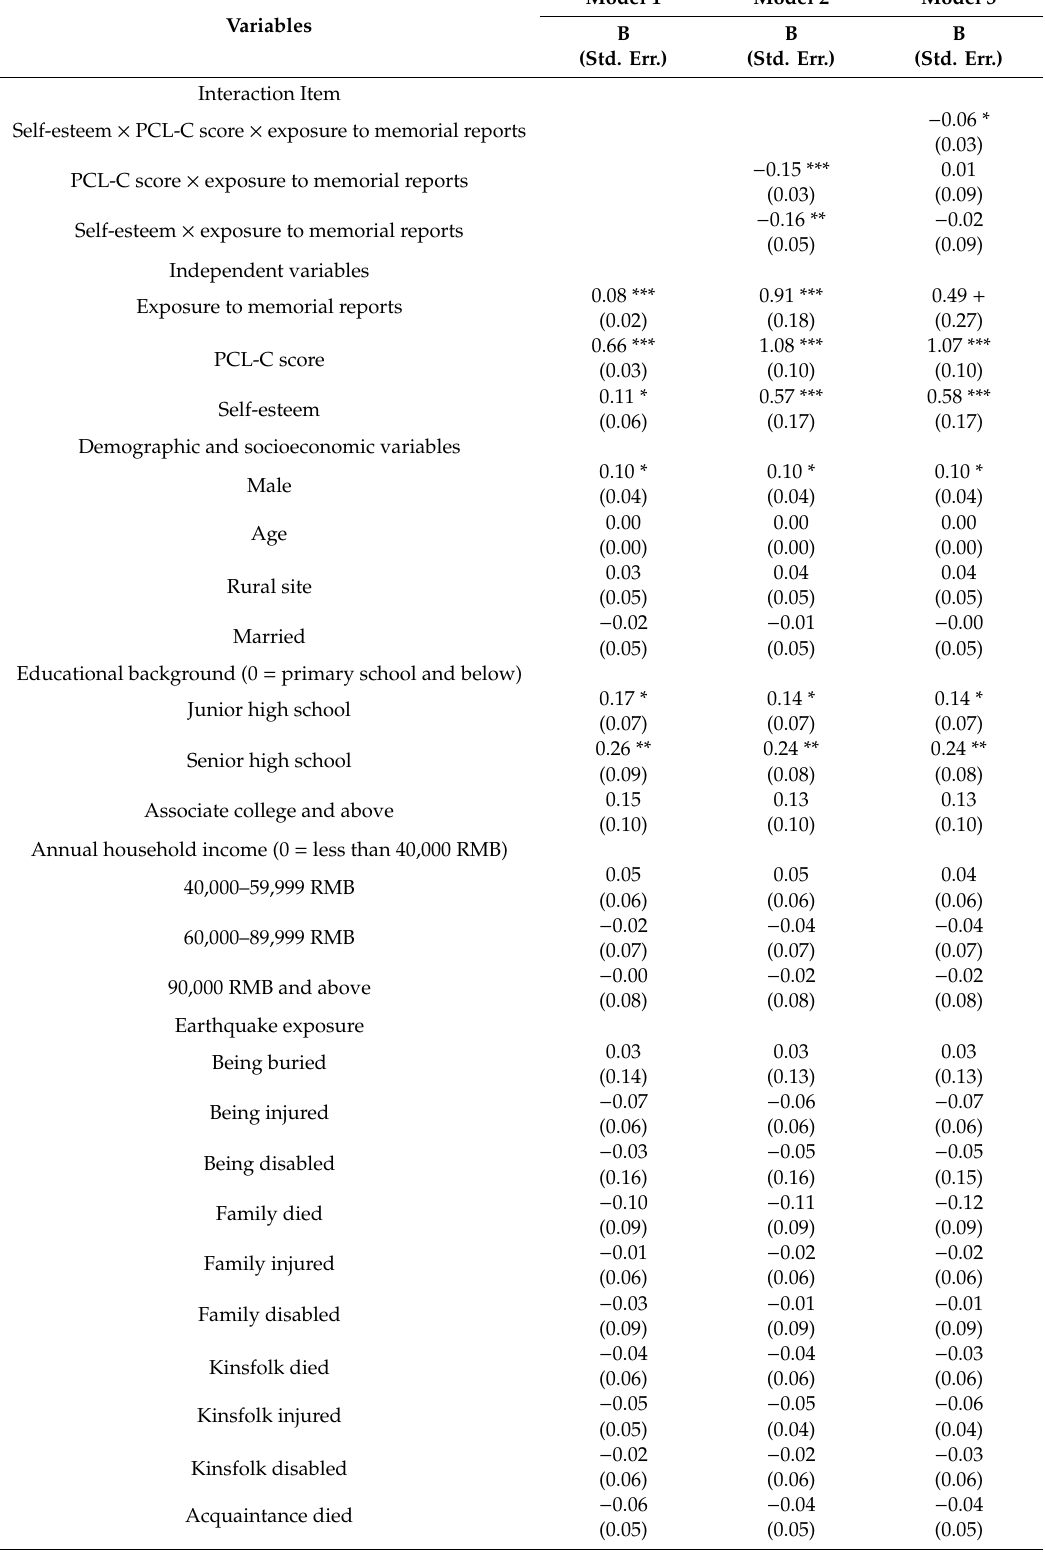
Table A1. Tobit regression model with coe ffi cients of all control variables. Model 1 Model 2 Model Variables